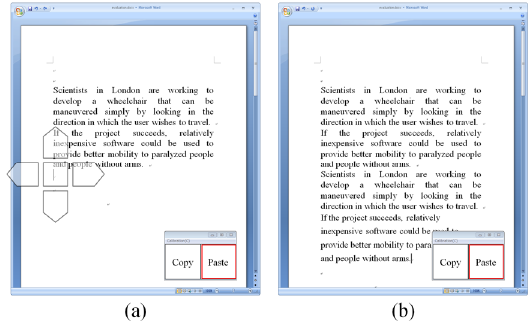
Fig. 10. Paste mode. (a) Setting the cursor to the paste point. (b) Result of